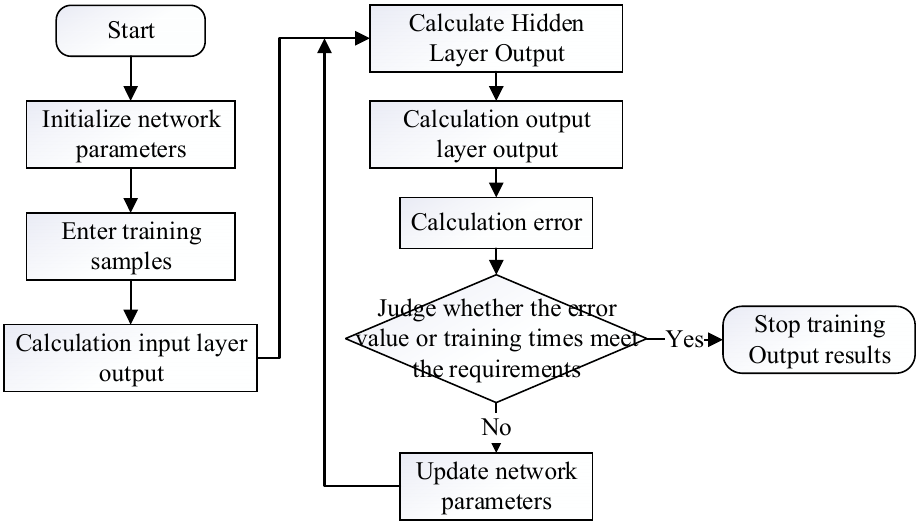
Figure 6. BP neural network training process.